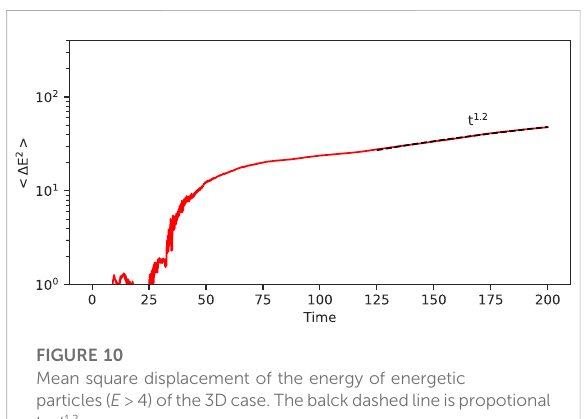
FIGURE 10 Mean square displacement of the energy of energetic particles( E > 4)ofthe3Dcase.Thebalckdashedlineispropotional to t 1.2